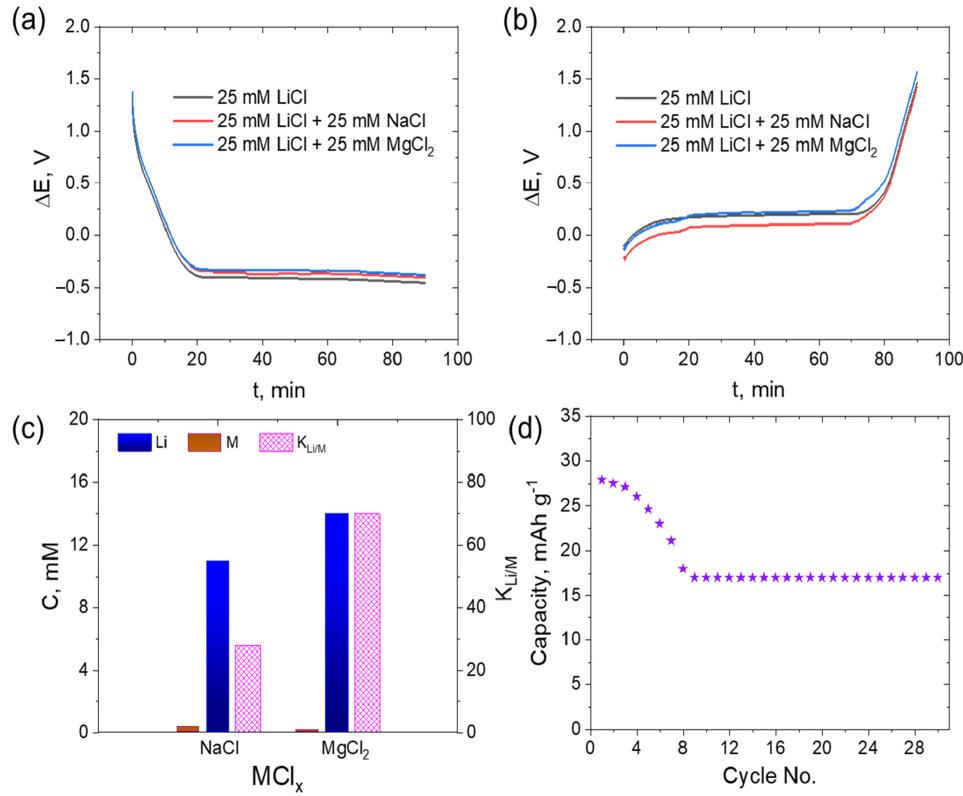
Figure 6. Voltage–time profile of ( a ) discharge cycle and ( b ) charge cycle of LiCl and LiCl containing NaCl or MgCl 2 . ( c ) Li + , Na + , and Mg 2+ concentrations after full cycle operation and the respective selectivity (K Li/M ). ( d ) Capacity over 30 cycles of operation using a 25 mM LiCl salt solution at a current density of ±0.5 mAcm −2 .